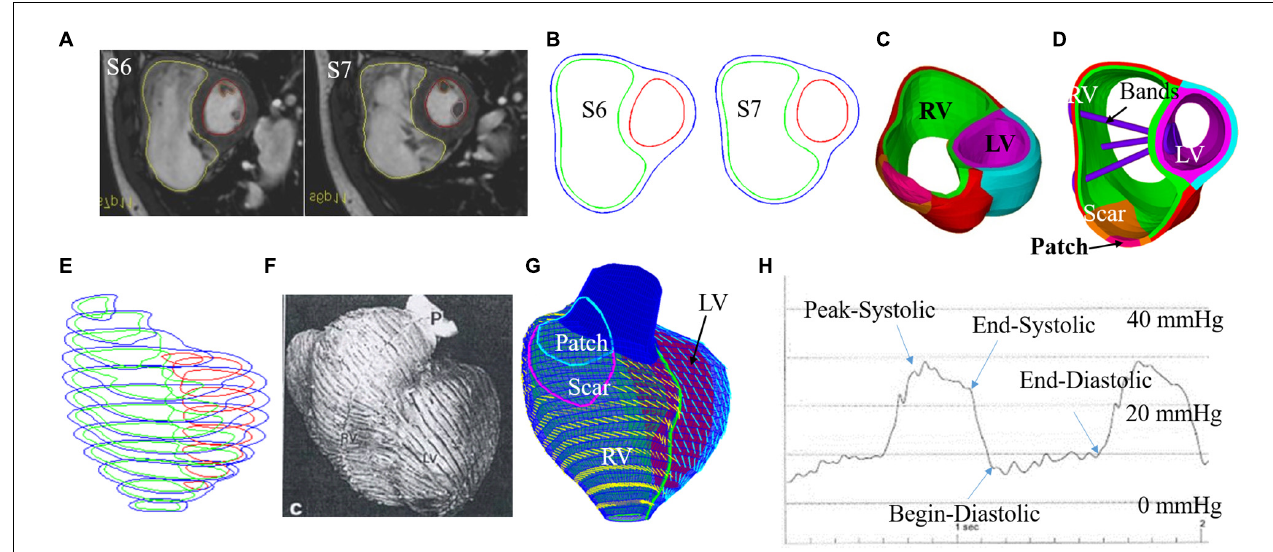
FIGURE 1 | CMR-based model construction process and pressure conditions. (A) Selected CMR slices from a patient, end of systole. (B) Segmented contours. (C) Two-layer structure. (D) . Ventricle with three bands inserted. (E) Stacked contours. (F) RV fiber orientation from a TOF patient. (G) Model with fiber orientations. (H) Recorded RV pressure profile (Tang et al., 2008, 2013; Yang et al., 2013; Yu et al., 2019, 2020).